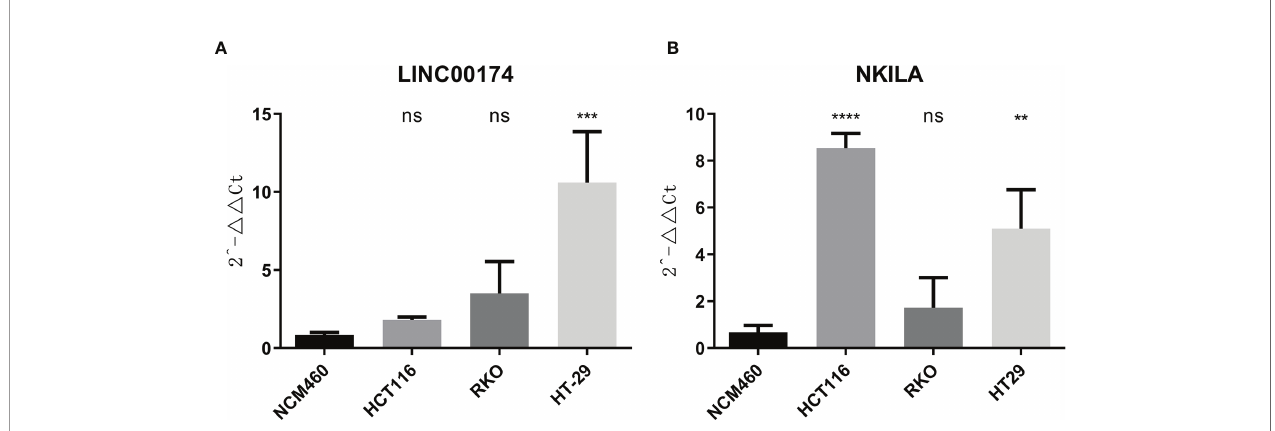
FIGURE 8 | The expression of LINC00174 and NKILA was detected by qRT-PCR. (A) The expression of LINC00174 among normal colonic epithelial cell line and colorectal cancer cell lines. (B) The expression of NKILA among normal colonic epithelial cell line and colorectal cancer cell lines. All p-values were the comparison of the lncRNA expression of HCT116, RKO, HT29, and that of NCM460. ****p < 0.0001; ***0.0001 < p < 0.001; **0.01 < p < 0.001; ns: p > 0.05.